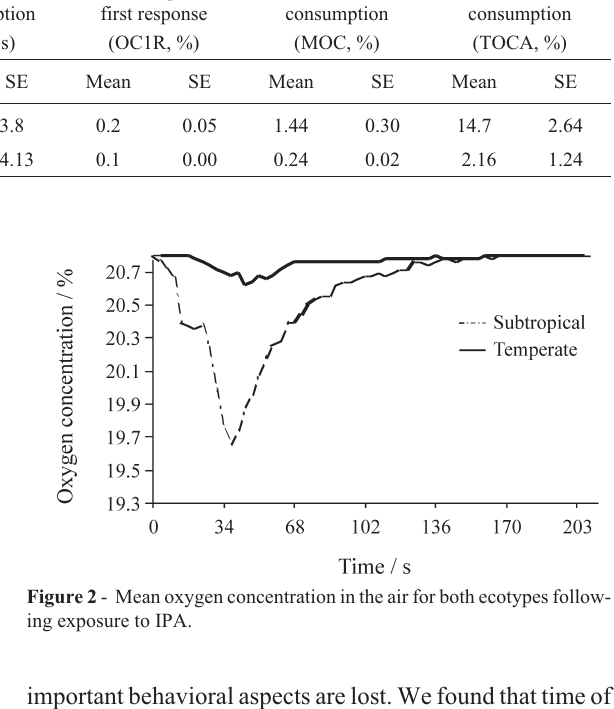
Table I - Response time and oxygen consumption for subtropical and temperate honeybee colonies. Honeybee ecotype